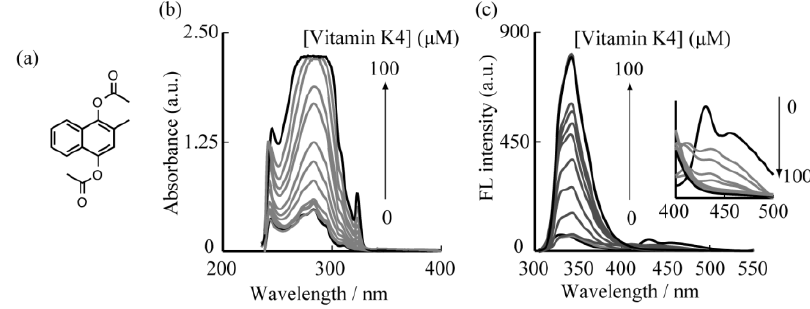
Figure 2. ( a ) Chemical structure of vitamin K4; ( b ) UV-vis and ( c ) fluorescence response of G2 dendrimer upon addition of vitamin K4. The inset shows fluorescence response of G2 dendrimer upon addition of vitamin K4 at 400–500 nm.